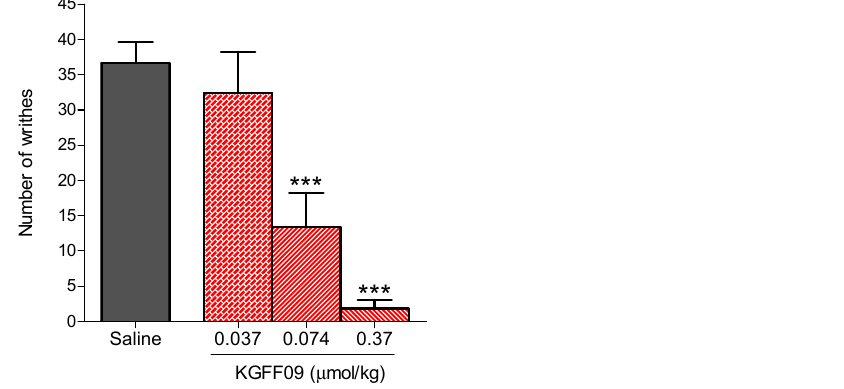
Figure 3. Antinociceptive effect of KGFF09 in the acetic acid-induced writhing test after s.c. adminis- tration in mice. Groups of mice received s.c. saline (control) or different doses of KGFF09 , and the number of writhes were counted at 30 min after drug administration for a period of 10 min. Values represent the mean ± SEM ( n = 6–8 mice per group). *** P < 0.001 vs. saline group, one-way ANOVA followed by Dunnett’s post-hoc